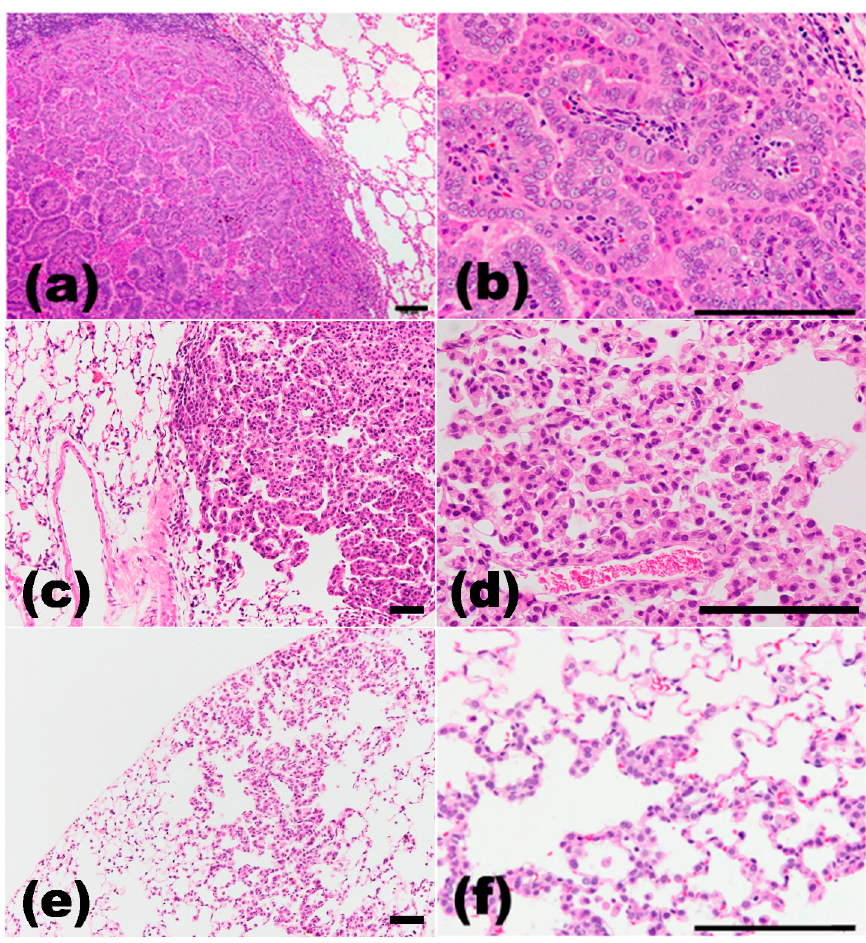
Figure 1. Histopathological findings in DHPN-induced rat lung proliferative lesions. ( a , b ), adeno- carcinoma; ( c , d ), adenoma; ( e , f ), hyperplasia. ( a , c , e ), low magnification; ( b , d , f ), high magnification. H&E staining. Scale bar, 100 μ m.